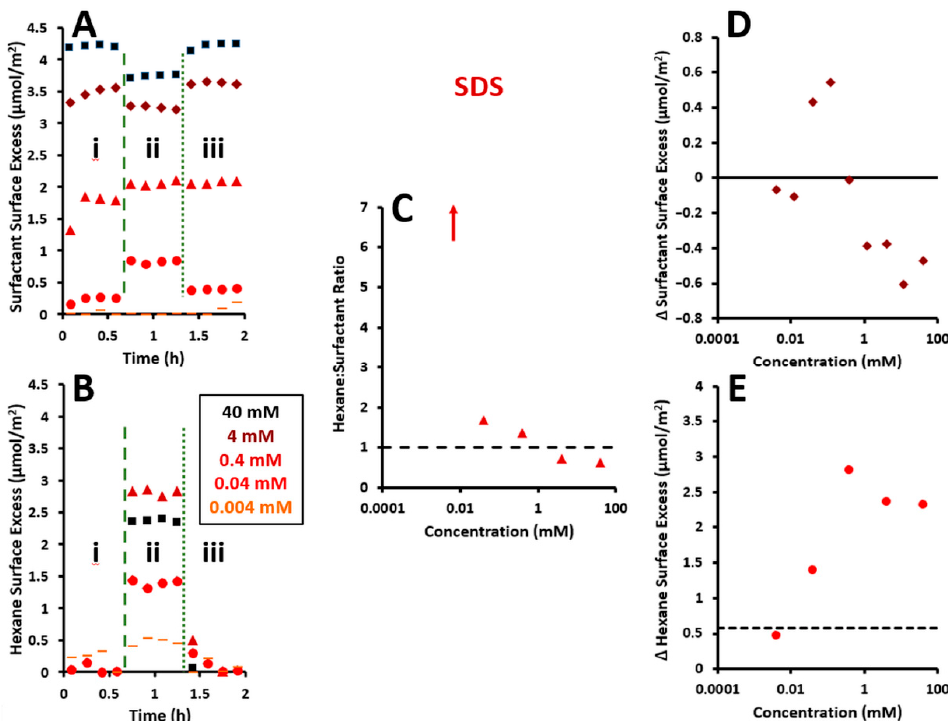
Figure 5. Surface excesses of ( A ) SDS and ( B ) hexane from neutron reflectivity measurements at the concentrations stated in the legends. Additional information about the nature of the data points in regions (i), (ii) and (iii) can be found in the caption to figure 2. ( C ) Surface excess molar ratios of hexane:SDS reached at equilibrium for the interactions of hexane vapor with adsorbed surfactant monolayers analyzed from neutron reflectivity measurements. The dashed lines simply highlight a molar ratio of unity for reference. The arrow notes a value of the interfacial stoichiometry off the shown scale, as in this case, the measured surfactant surface excess was minimal. Change in surface excesses of the ( D ) SDS and ( E ) hexane from neutron reflectivity measurements. Additional information about how the data were averaged can be found in the caption to figure 3. The dashed line in panels E represent the surface excess of hexane adsorbed at a bare water/air interface of 0.57 μ mol/m 2 .